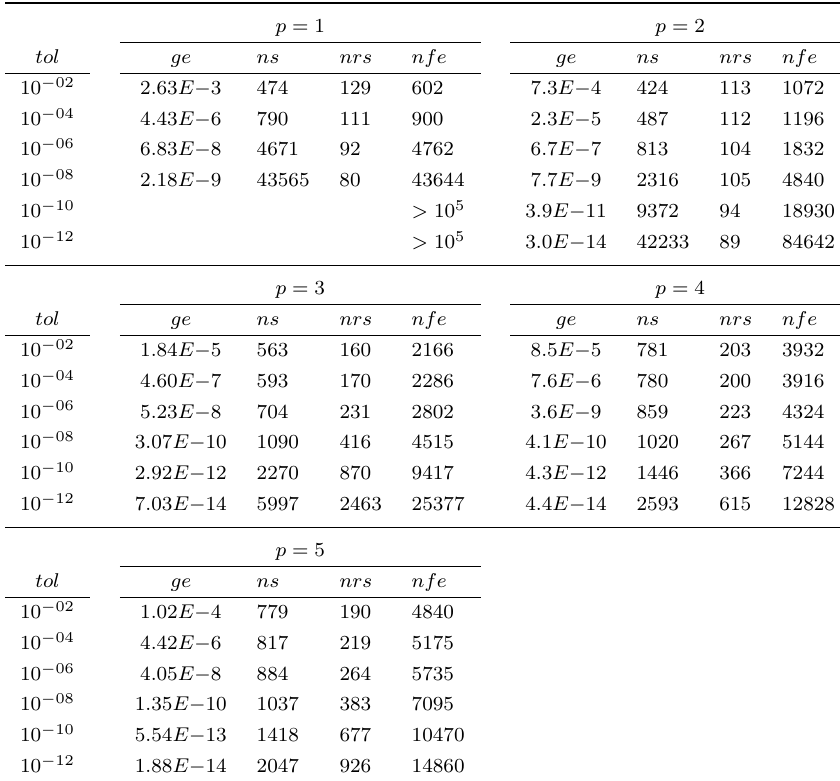
Table 3. Results of numerical experiments for Prothero-Robinson problem (4.2) on t ∈ [0 , 100] with standard stepsize changing